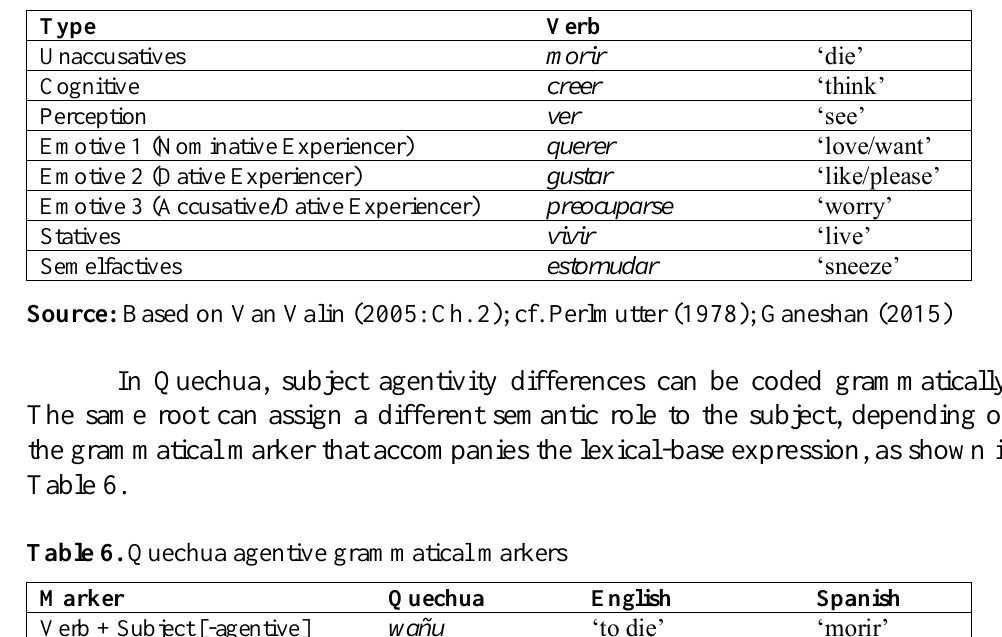
Table 5. Verbs with a non-agentive subject